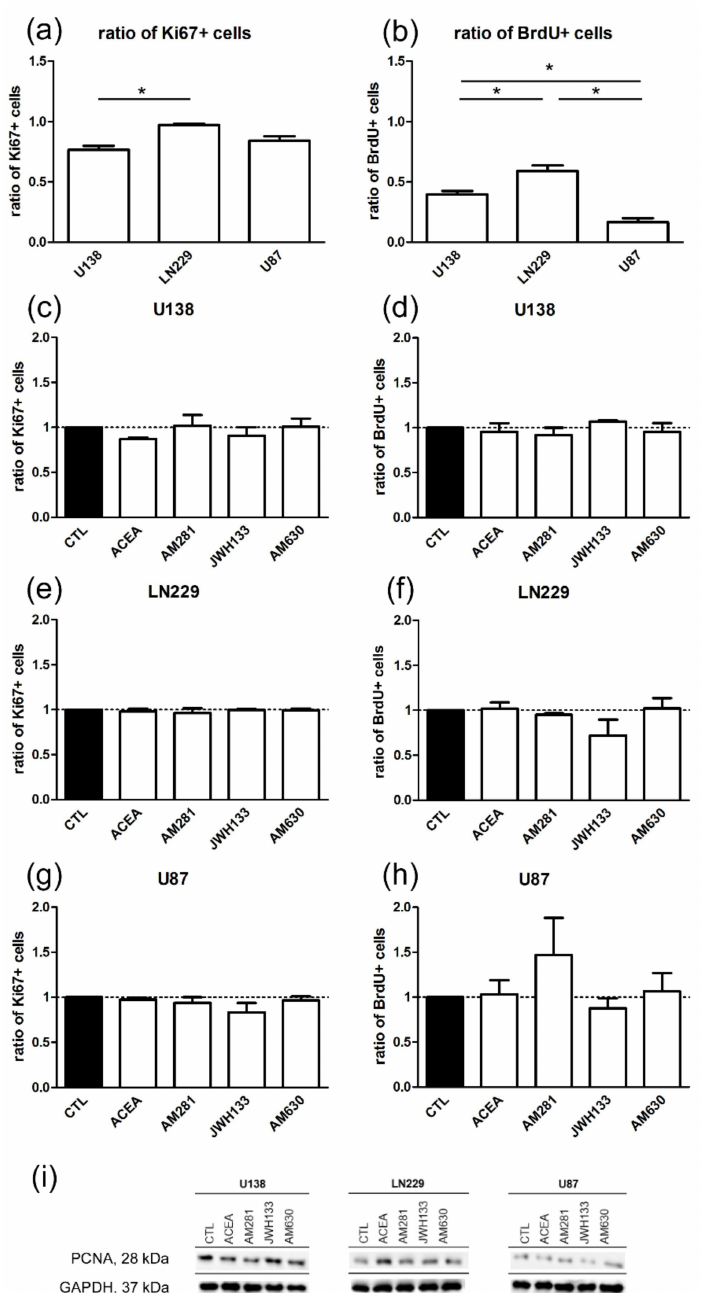
Figure 2. No changes in the proliferation index could be observed in U-138 MG, LN229, and U-87 MG cell lines after treatment with agonists (ACEA, 10 µ M; JWH133, 10 µ M) and antagonists (AM281, 1 µ M; AM630, 1 µ M) for CB 1 and CB 2 for 24 h. Differences occurred in the basal level of proliferation between the cell lines. Control groups of U-138 MG, LN229, and U-87 MG cell lines were compared in the ratio of positive cells for ( a ) Ki67 ( n U138 = 4, n LN229 = 3, n U87 = 4) and ( b ) bromodeoxyuridine (BrdU) ( n U138 = 3, n LN229 = 4, n U87 = 3). All cell lines had a significantly different expression of S-phase marker Brdu. The Ki67 index was significantly different between U-138 MG and LN229. LN229 cells have the highest level of proliferating cells followed by U-138 MG. Application of ACEA, AM281, JWH133, and AM630 did not influence the ratio of the BrdU and Ki67 positive cells in ( c , d ) U-138 MG ( n CTL = 3, n ACEA = 3, n AM281 = 3, n JWH133 = 3, n AM630 = 3); ( e , f ) LN229 ( n CTL = 3, n ACEA = 3, n AM281 = 3, n JWH133 = 3, n AM630 = 3); and ( g , h ) U-87 MG cells ( n CTL = 3, n ACEA = 3, n AM281 = 3, n JWH133 = 3, n AM630 = 3). ( i ) Representative Western Blots of G1 and S-phase marker, proliferating nuclear antigen (PCNA) and glyceraldehyde 3-phosphate dehydrogenase (GAPDH) show no significant differences between the groups. All data were normalized to the control